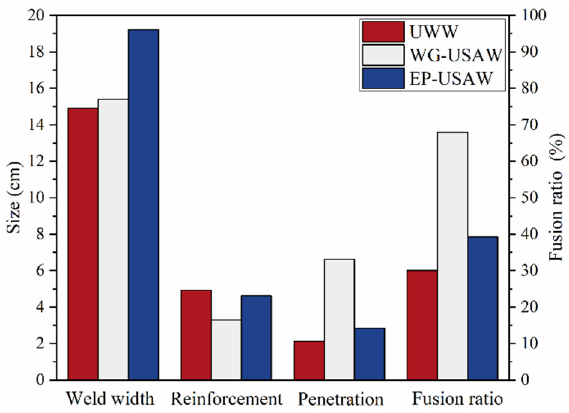
Figure 3. Geometry parameter statistics of welds formation.